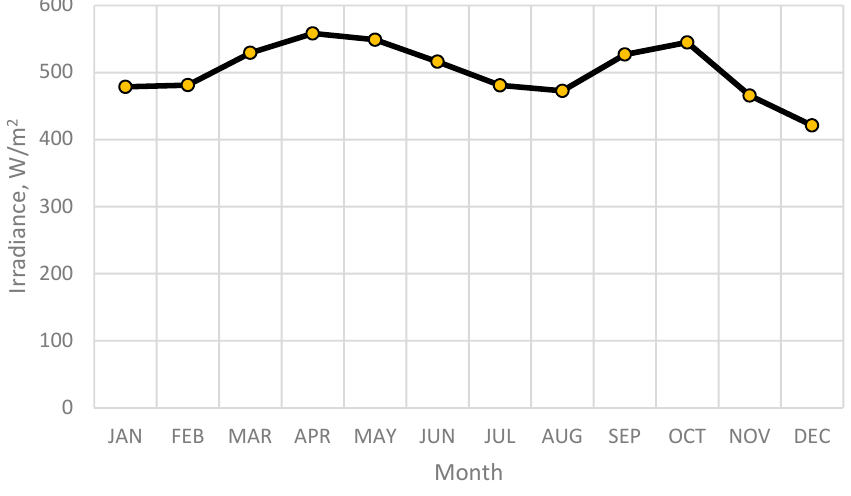
Figure 2. Monthly average solar irradiance (W/m 2 ) for two years (2020 and 2021).